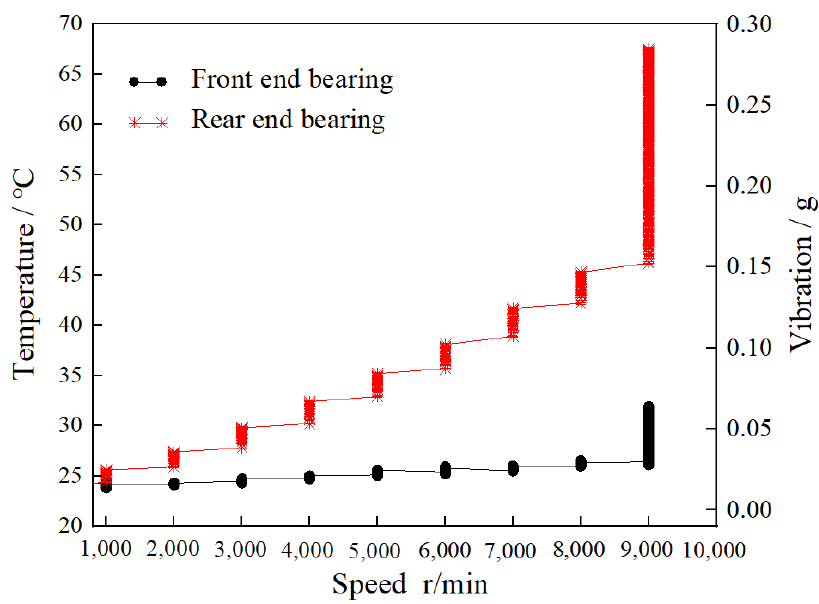
Figure 3. High-speed durability testing of high-performance bearings.